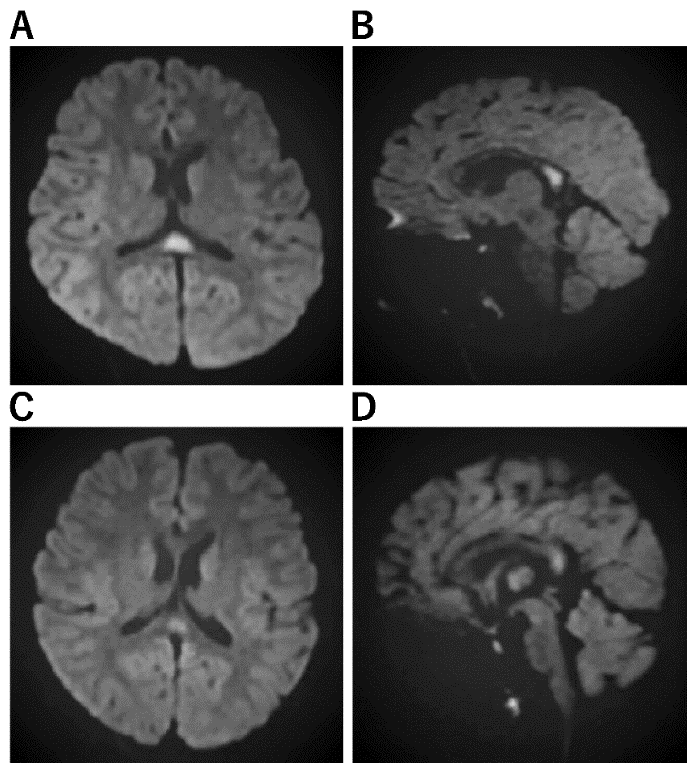
Figure 1. Imaging Characteristics of MERS. ( A , B ): A Horizontal/B sagittal section was performed on an 8-year-old boy who had an MRI on the third day of fever due to impaired consciousness and unable to recognize his own name. DWI showed an abnormal high signal in the cerebral corpus callosum: WBC 24800, CRP 7.84, Na 133, CL 95, ferritin 119.9, IL-6 171 EEG showed high amplitude slow waves in the occipital region. After 3 days of steroid pulse therapy, the fever resolved and consciousness improved. No sequelae. No causative organism or virus could be identified. ( C , D ): On the third day of vomiting and fever, he was hospitalized because he could no longer talk to his mother and could not look at her. He had diarrhea and was positive for rotavirus antigen in stool. In the bilateral frontal and occipital regions, EEG revealed persistent high amplitude slow waves. He was diagnosed with MERS on the fifth day after a diffusion-weighted MRI revealed an abnormally high signal in the corpus callosum. mPSL steroid pulse therapy was administered for three days, his level of consciousness improved, and both EEG and MRI were